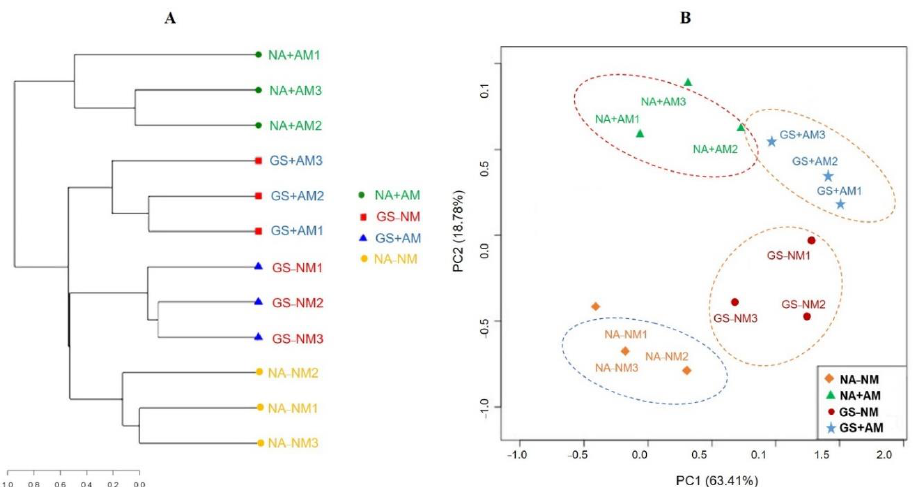
Figure 5. Clustering analysis of AMF communities ( A ), and principal component analysis ( B ) of the different soil samples based on OTU abundance.